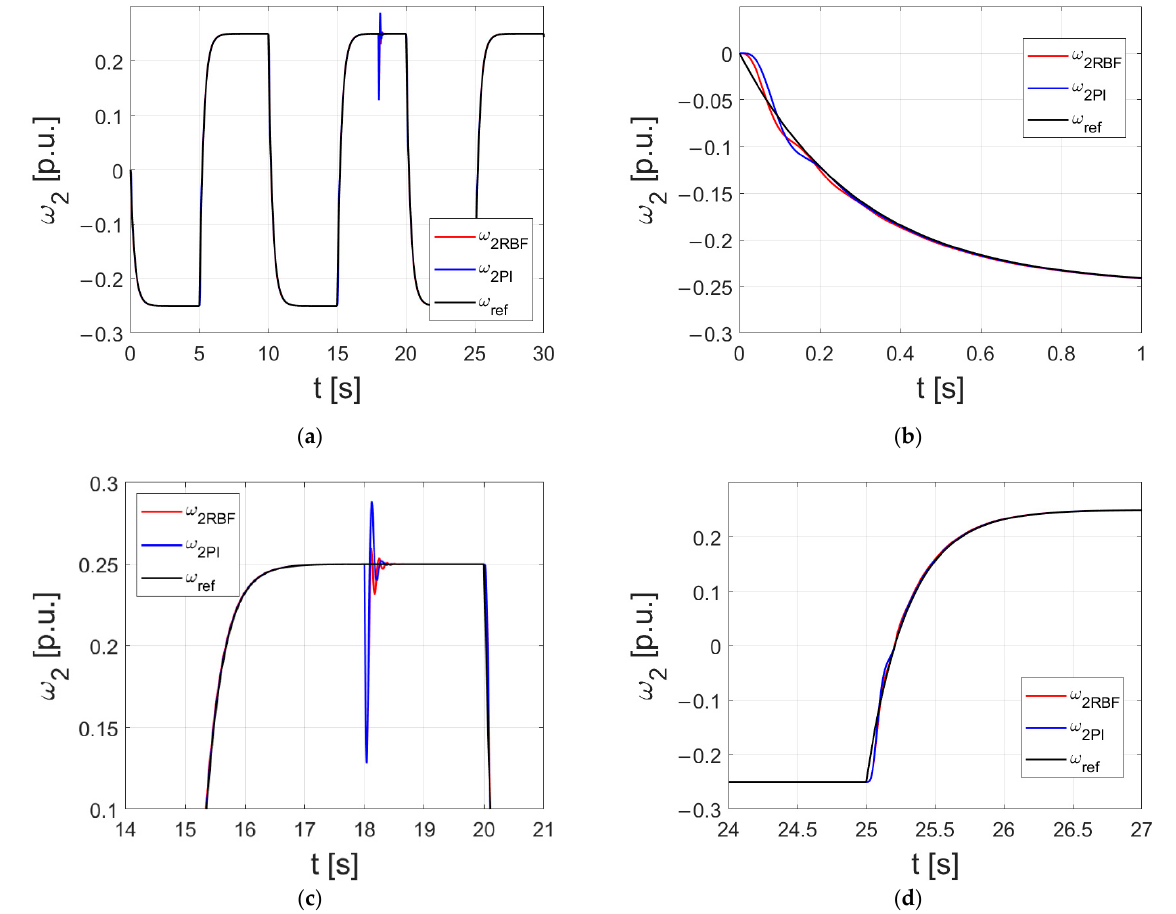
Figure 5. Simulation results—the hybrid controller structure testing: ( a ) a general overview of the simulation run; ( b ) a zoom-in showing the initial stage of the simulation; ( c ) a zoom-in showing the work of the controller when the load is switched on; ( d ) a zoom-in showing the operation of the drive with the nominal load switched on.